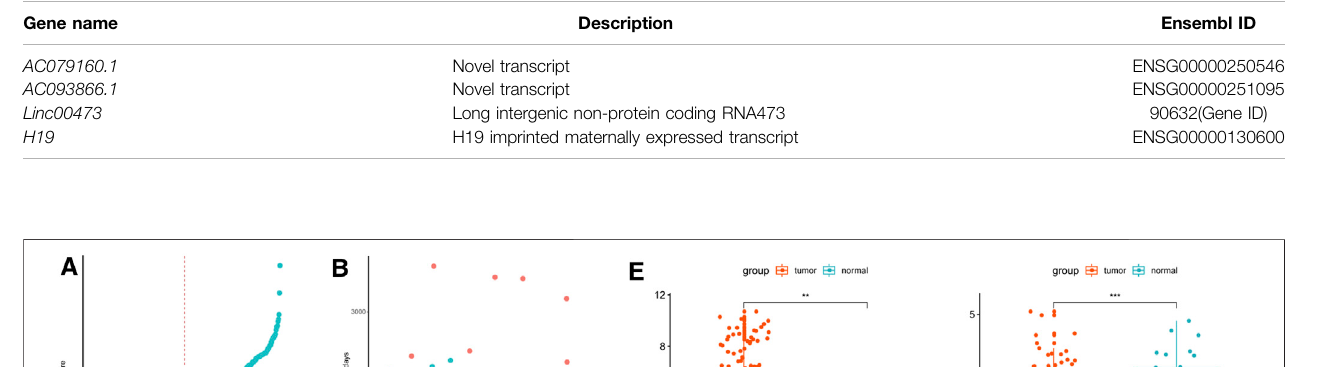
Frontiers in Genetics |